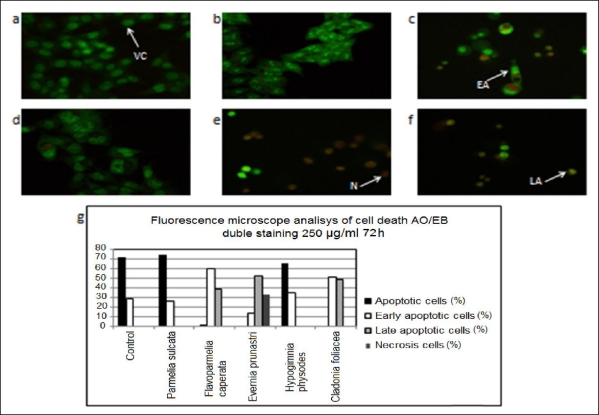
The effect of the lichen extracts on apoptosis of HCT-116 cells after 72 h exposure monitored by the acridine orange/ethidium bromide staining: (a) Untreated, control cells; (b) Cells treated with Parmelia sulcata extract; (c) Cells treated with Flavoparmelia caperata extract; (d) Cells treated with Evernia prunastri extract; (e) Cells treated with Hypogymnia physodes extract; (f) Cells treated with Cladonia foliacea extract. Magnification on fluorescent microscope was 400×; (g) Grafic representation of obtained data. VC – viable cell, EA – early apoptotic cell, LA – late apoptotic cell, N – necrotic cell.